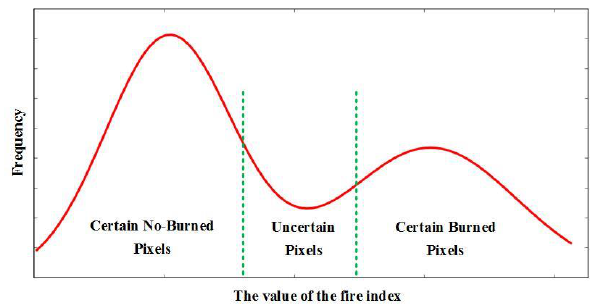
Figure 2. Uncertainty analysis of enhanced fire